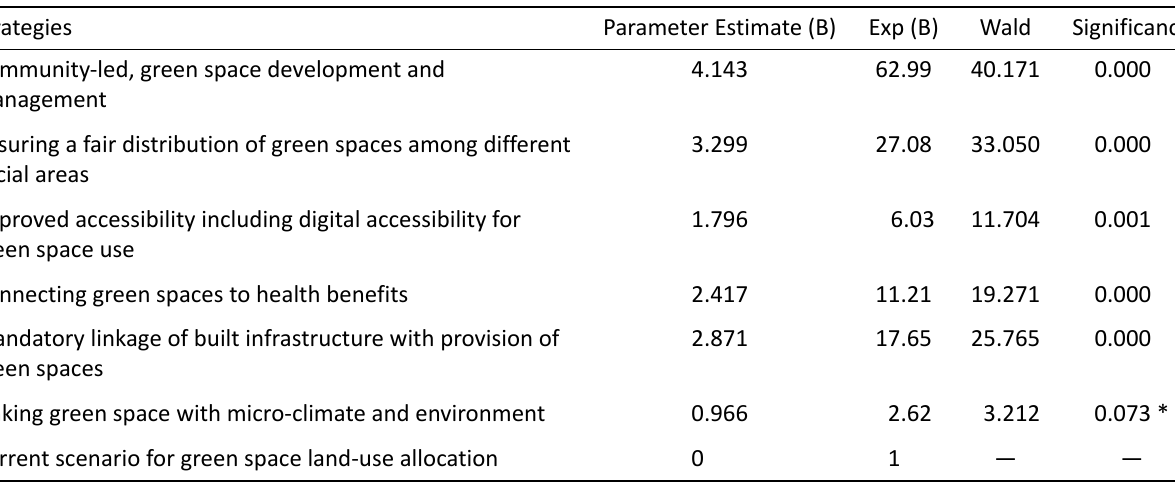
Table 8. Strategies for improving environmental justice and social inclusivity in the development and management of orga‐ nized green